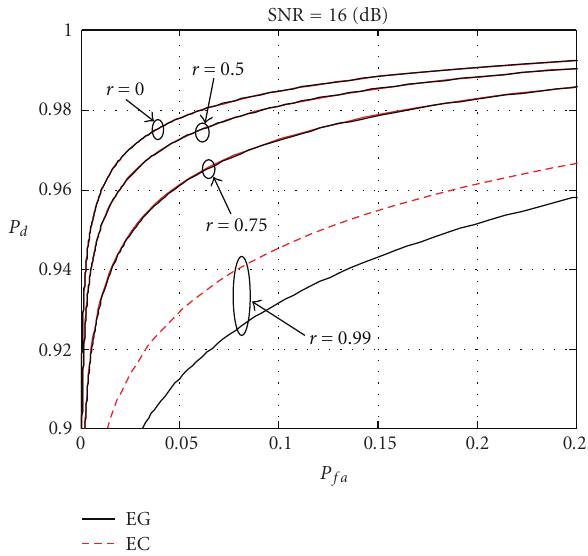
Figure 5: ROC curves for given SNR and r .